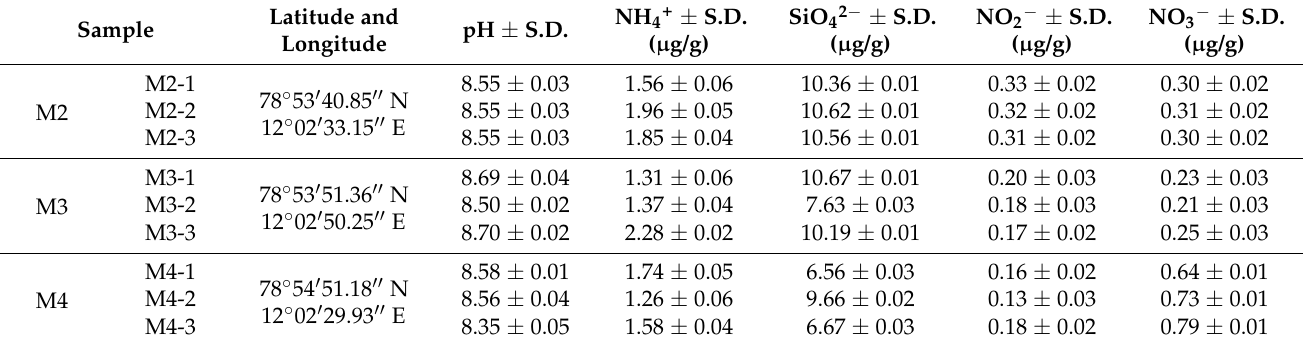
Table 2. Soil sampling information at different